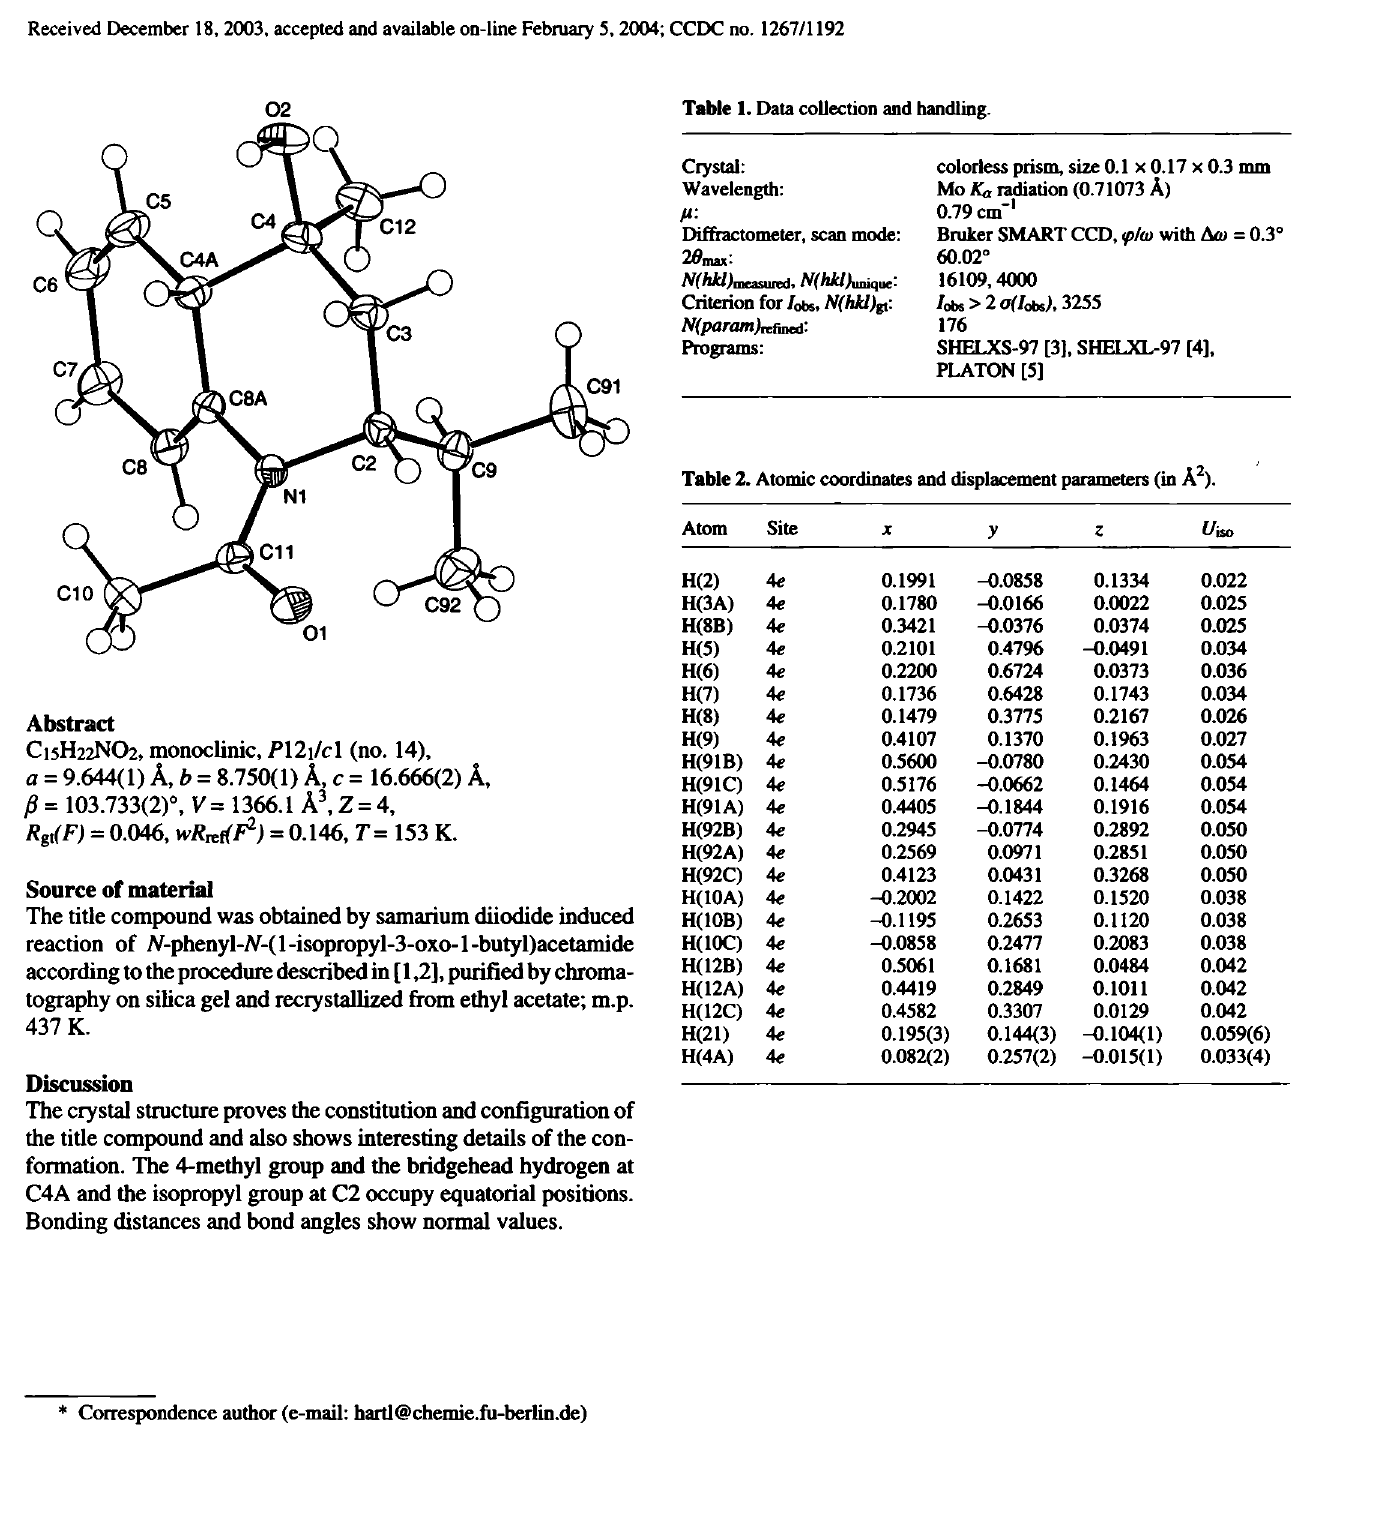
Table 1. Data collection and handling.